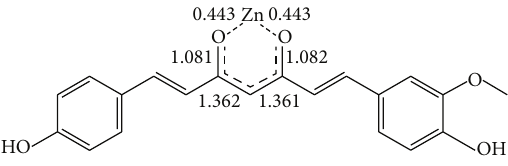
Figure 6: Bond orders of [dCurc-H + Zn] +